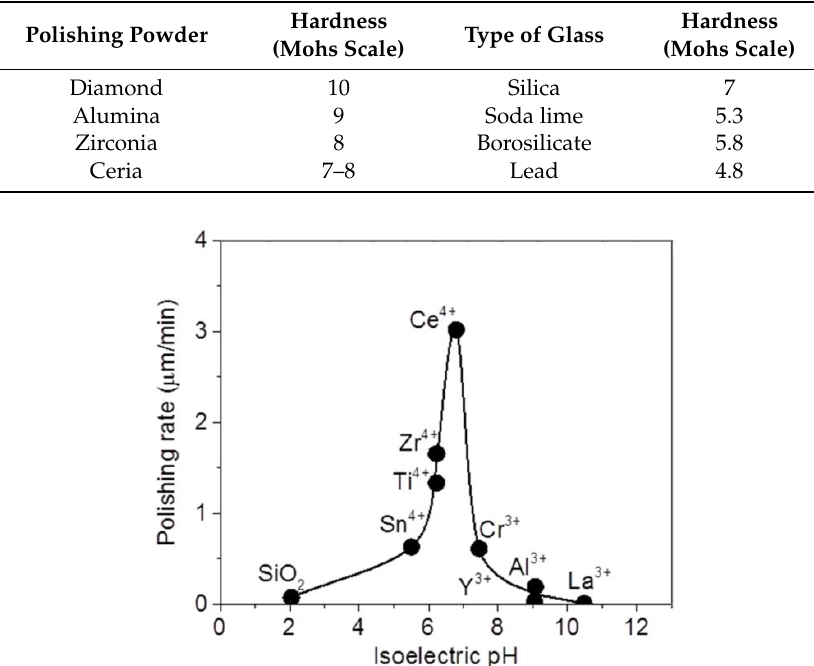
Figure 1. Relation between isoelectric pH (where the concentrations of positively and negatively charged species at the surface are equal) of different polishing compounds with respect to glass polishing rate data. Reproduced from Cook [10], with permission from Elsevier, 2018.